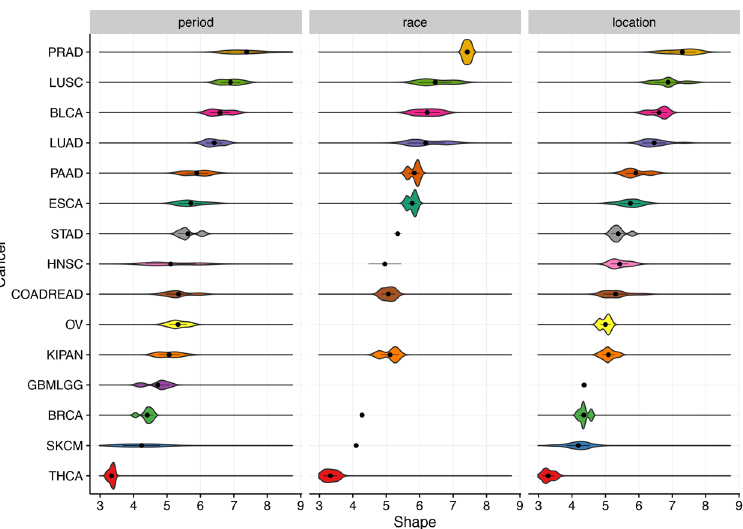
Figure 3. Shape parameters estimated by fitting empirical cancer incidence data using the Weibull function (data with ages for up to 85 years). Cancer patients are grouped by year of diagnosis, race and registry. Cancers are ordered by median values of shape. Shapes are uniform regardless of risk factors, which is consistent with intuitive expectations: race and environmental changes are less likely to alter the number of driver events for cancer